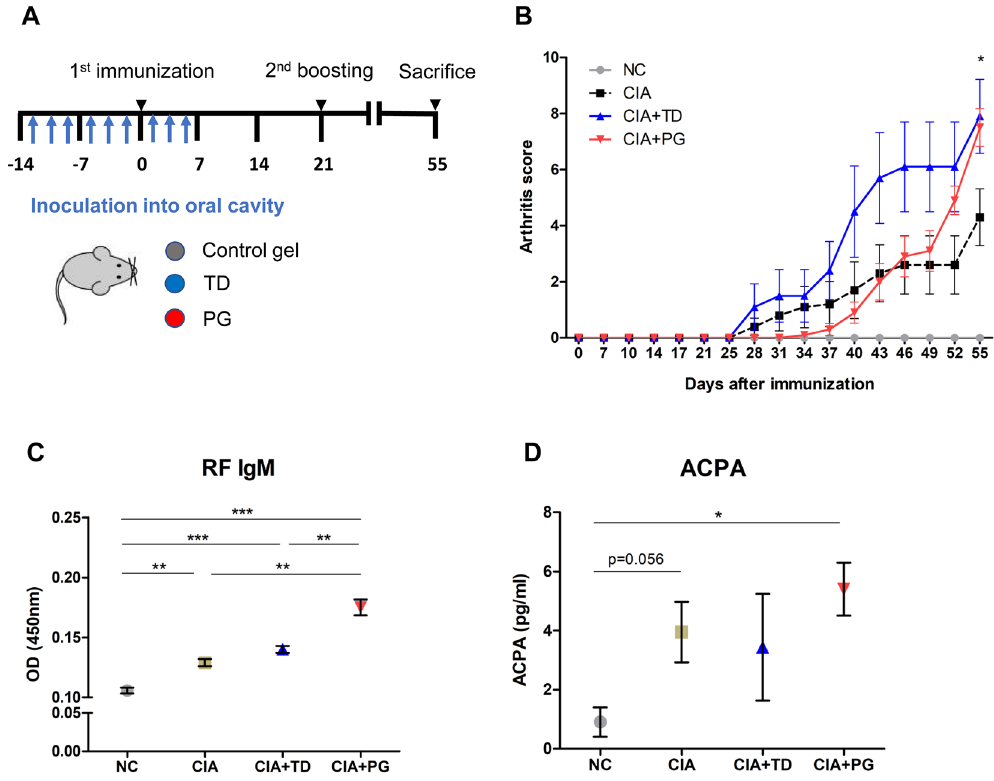
Figure 3. Different degrees of RF induction in collagen-induced arthritis (CIA) mouse models inoculated with different species of periodontal bacteria. ( A ) Schematic illustration of CIA model development and oral inoculation with or without periodontal bacteria, Porphyromonas gingivalis and T. denticola . ( B ) Changes in arthritis score of normal control mice (n = 5), CIA mice inoculated with control gels (n = 10), CIA mice inoculated with P. gingivalis -containing gels (n = 10), and CIA mice inoculated with T. denticola -containing gels (n = 10) since first immunization with type II collagen. ( C ) Levels of RF IgM in different mouse groups 55 days after the first immunization (n = 3 in each group). ( D ) Levels of anti-citrullinated protein antibodies (ACPAs) in different mouse groups 55 days after the first immunization (n = 3 in each group). Data are representative